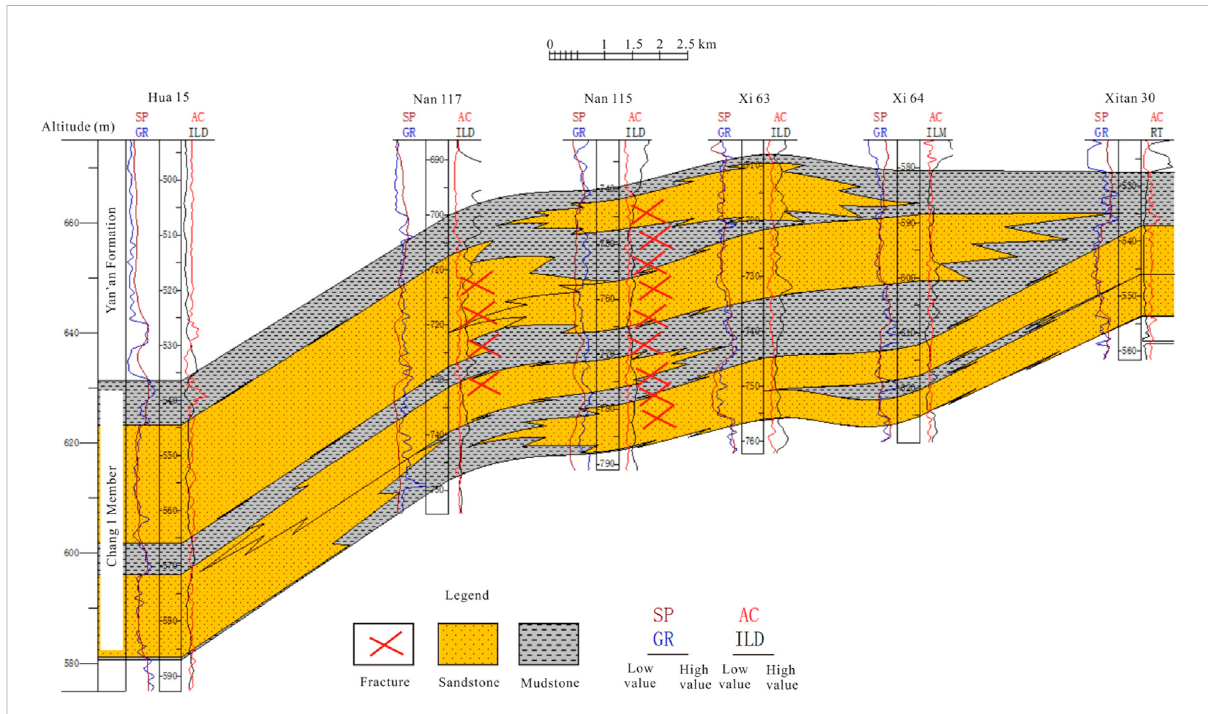
FIGURE 9 Sand bodypro fi le ofconnecting wellsinChang1 Member ofthestudy area.SP standsfor spontaneouspotential;GR standsfor naturalgamma; AC stands for acoustic time difference; ILD stands for deep lateral resistivity; ILM stands for medium induced resistivity; RT stands for true